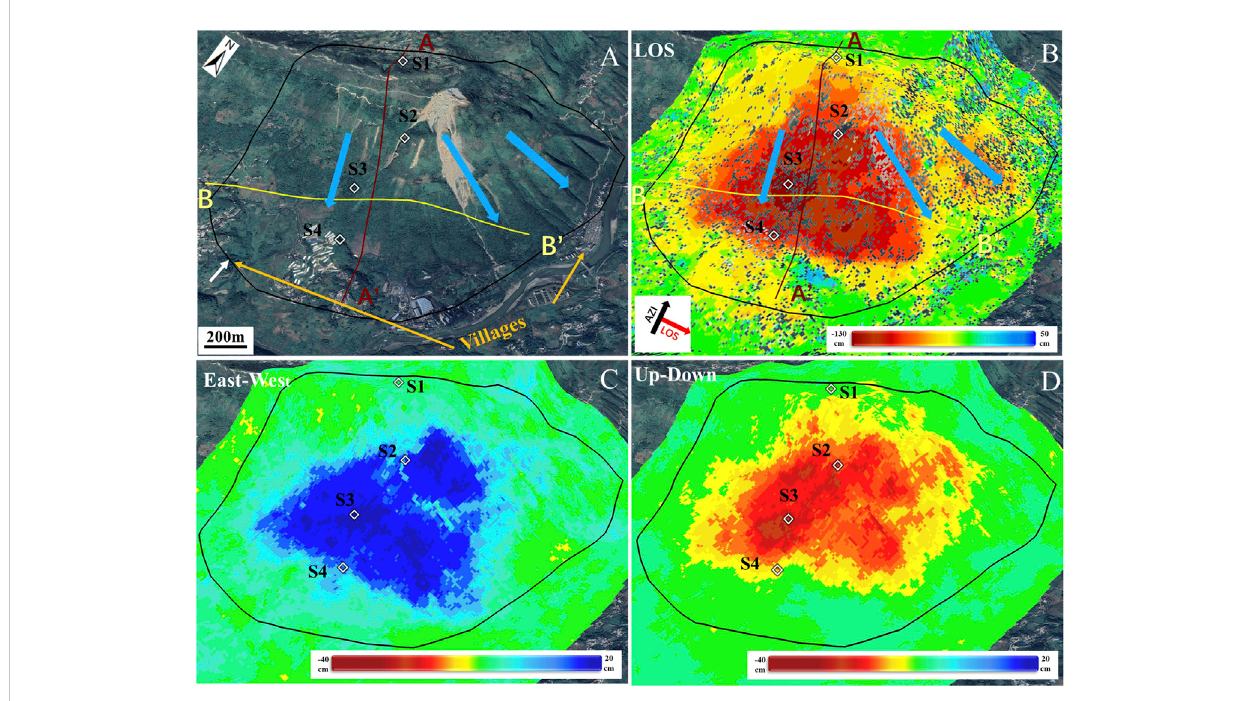
FIGURE 8 Perspective view of optical image and InSAR deformation maps. (A) Google-earth image acquired on 11 November 2020; (B) ALOS/PALSAR-2 LOS cumulative deformation map, where thepro fi les AA ’ and BB ’ isshow inFigure11,and thedeformationtime series atpoints S1, S2,S3 andS4 are displayed in Figure 10; (C) and (D) are the east-west and vertical annual deformation rate maps derived from ascending and descending Sentinel-1A images,